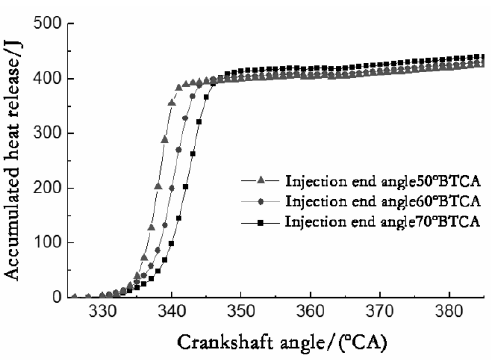
Figure 11. Cumulative heat release at different injection end angles.